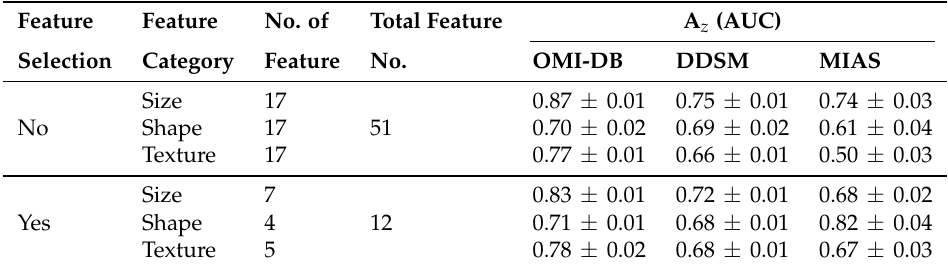
Table 3. A z estimation for the classification of MC clusters while applying 10-fold CV using ensemble learning on segmented image using a block size based on clinical